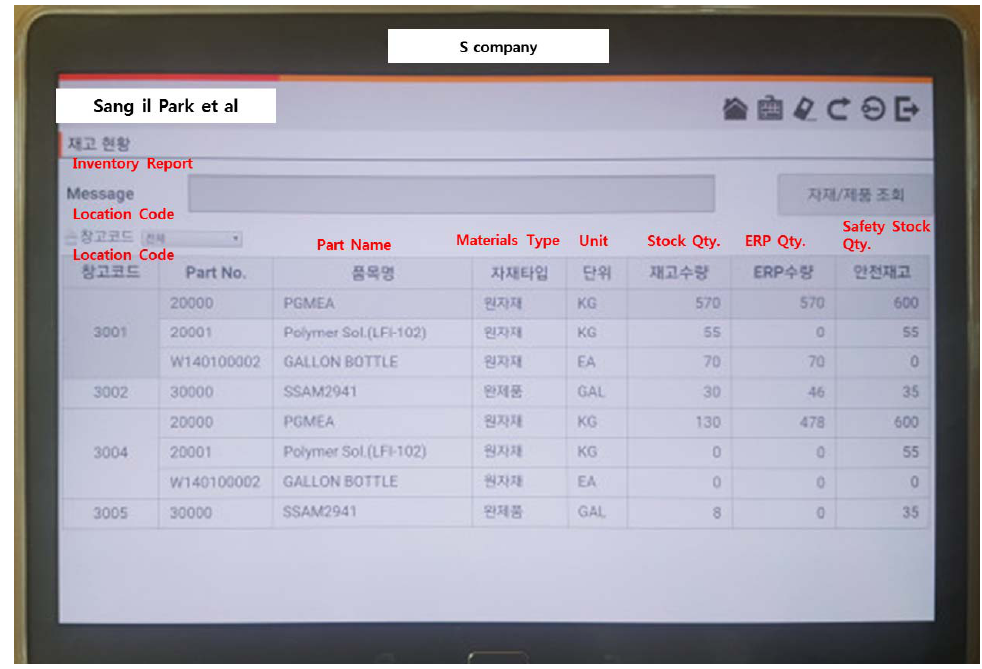
Figure 21. System Configuration of the Smart Factory Using Smart PAD.